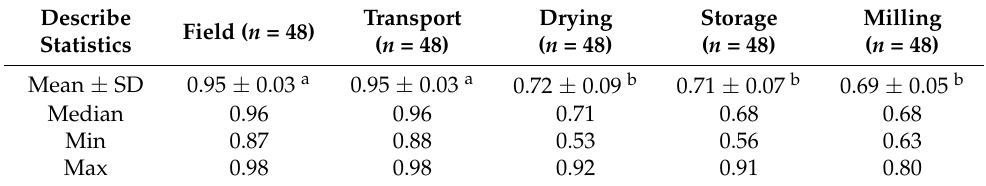
Table 3. Water activity of paddy and white rice ( n = 240) (Mean ± SD) in Mekong Delta in